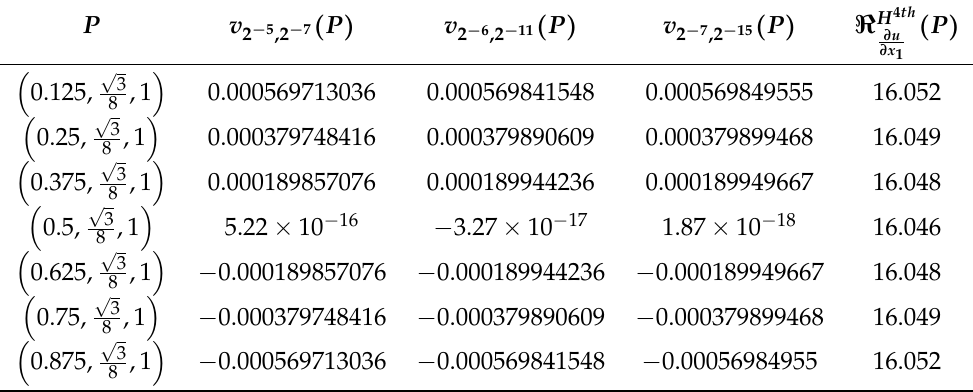
Table 4. The numerical solution v h , τ at seven points when t = 1, and the convergence orders obtained ) for the Example 2. by H 4 th ( ∂ u ∂ x 1